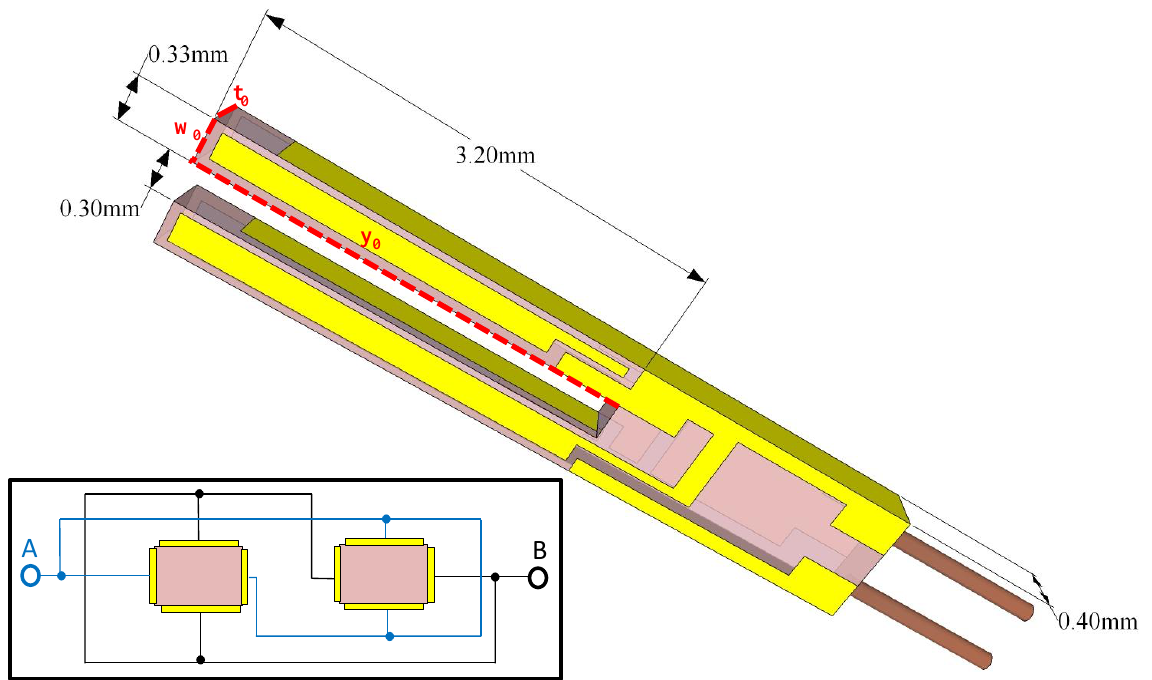
Figure 2. Schematic of a quartz tuning fork. Each prong can be modeled as a rectangular bar of dimension w y t (dotted lines). Inset: a top view of the tuning fork with the 0 0 electrical configuration for the electrodes A and